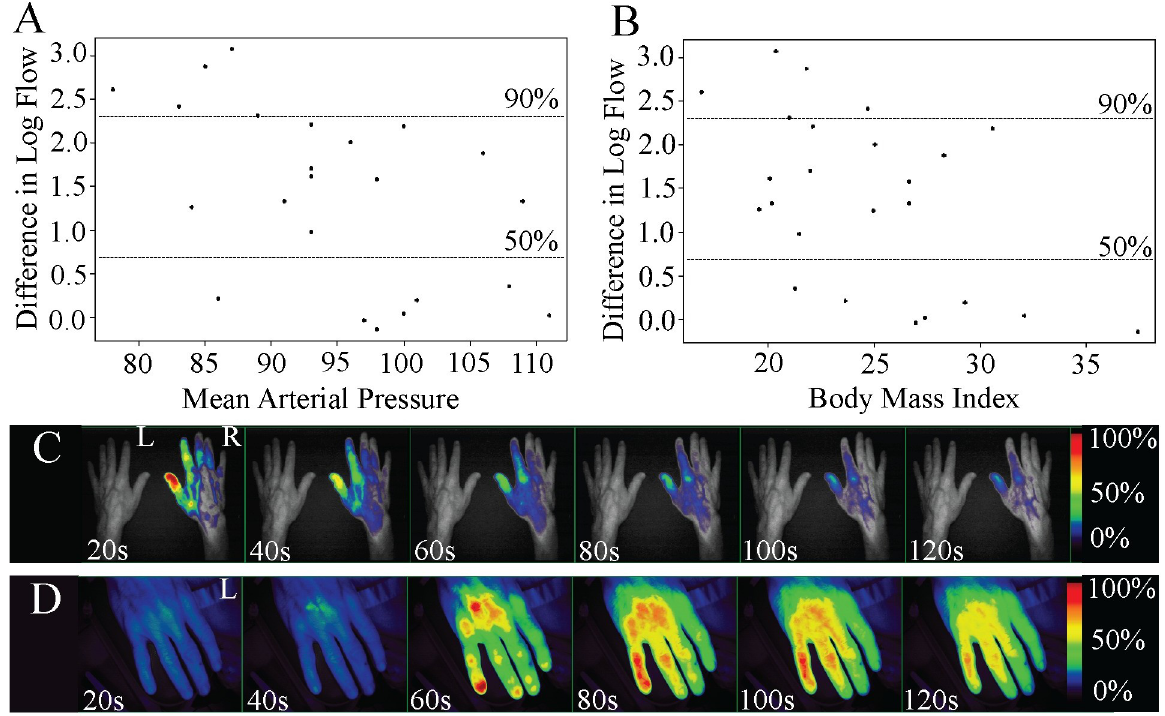
Fig 3. Plasma flow distal to the tourniquet in human subjects. Greater restrictions in flow during tourniquet were associated with A) lower MAP in the tourniqueted arm (r = -0.525) and B) lower BMI (r = -0.524). DLF of 90% or greater was significantly associated with lower MAP ( p = 0.018) and lower BMI ( p = 0.003). A subject who showed C) no detectable flow in the tourniqueted arm (L) with a 21-inch imaging distance demonstrated D) detectable ICG in the tourniqueted arm when the imaging distance was decreased to 7 inches. Dorsal view. Fluorescent signal indicates ICG detection. Relative fluorescence by percent